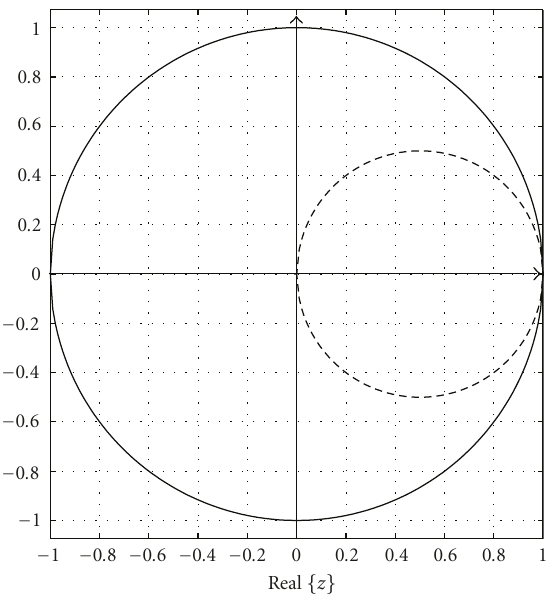
Figure 1: Image of jω axis in the z -plane for bilinear transform and the forward di ff erence method. Solid: bilinear transform, dashed: forward di ff erence